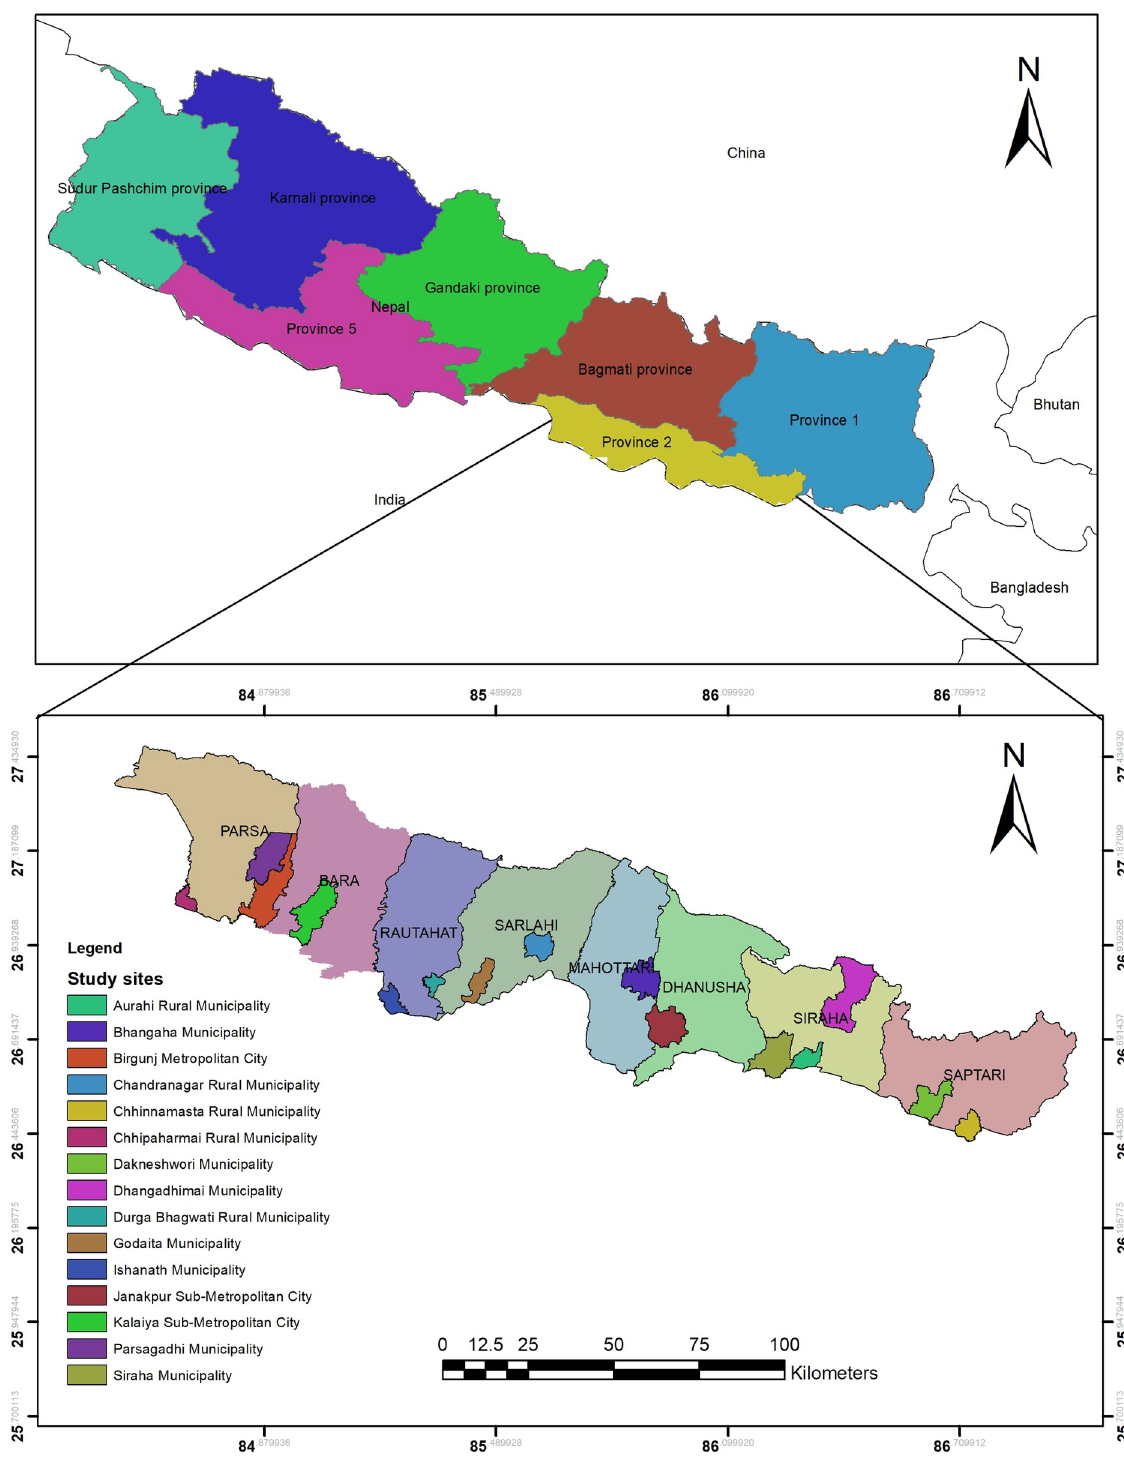
Fig 1. Map showing urban and rural study sites in eight districts in Province 2 of Nepal. The map was created using ArcGIS software V.10.8, and base files of the administrative provinces and districts of Nepal were obtained from the Government of Nepal, Ministry of Land Management, and Natural Earth, that is publicly available without restrictions (http://dos.gov.np/nepal-map) [35].